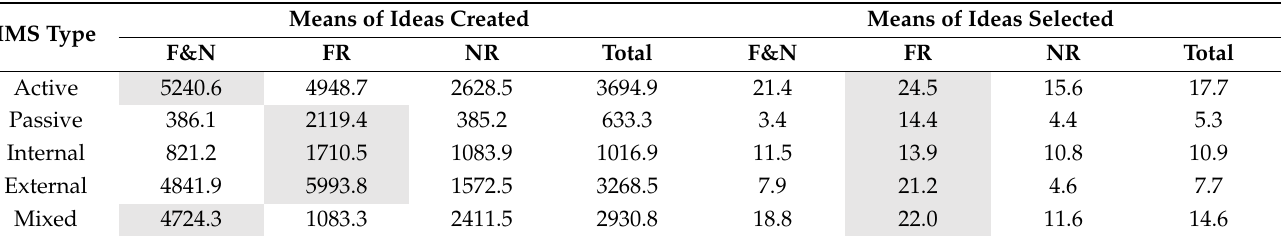
Table 11. Mean values of ideas created and selected by the rewards’